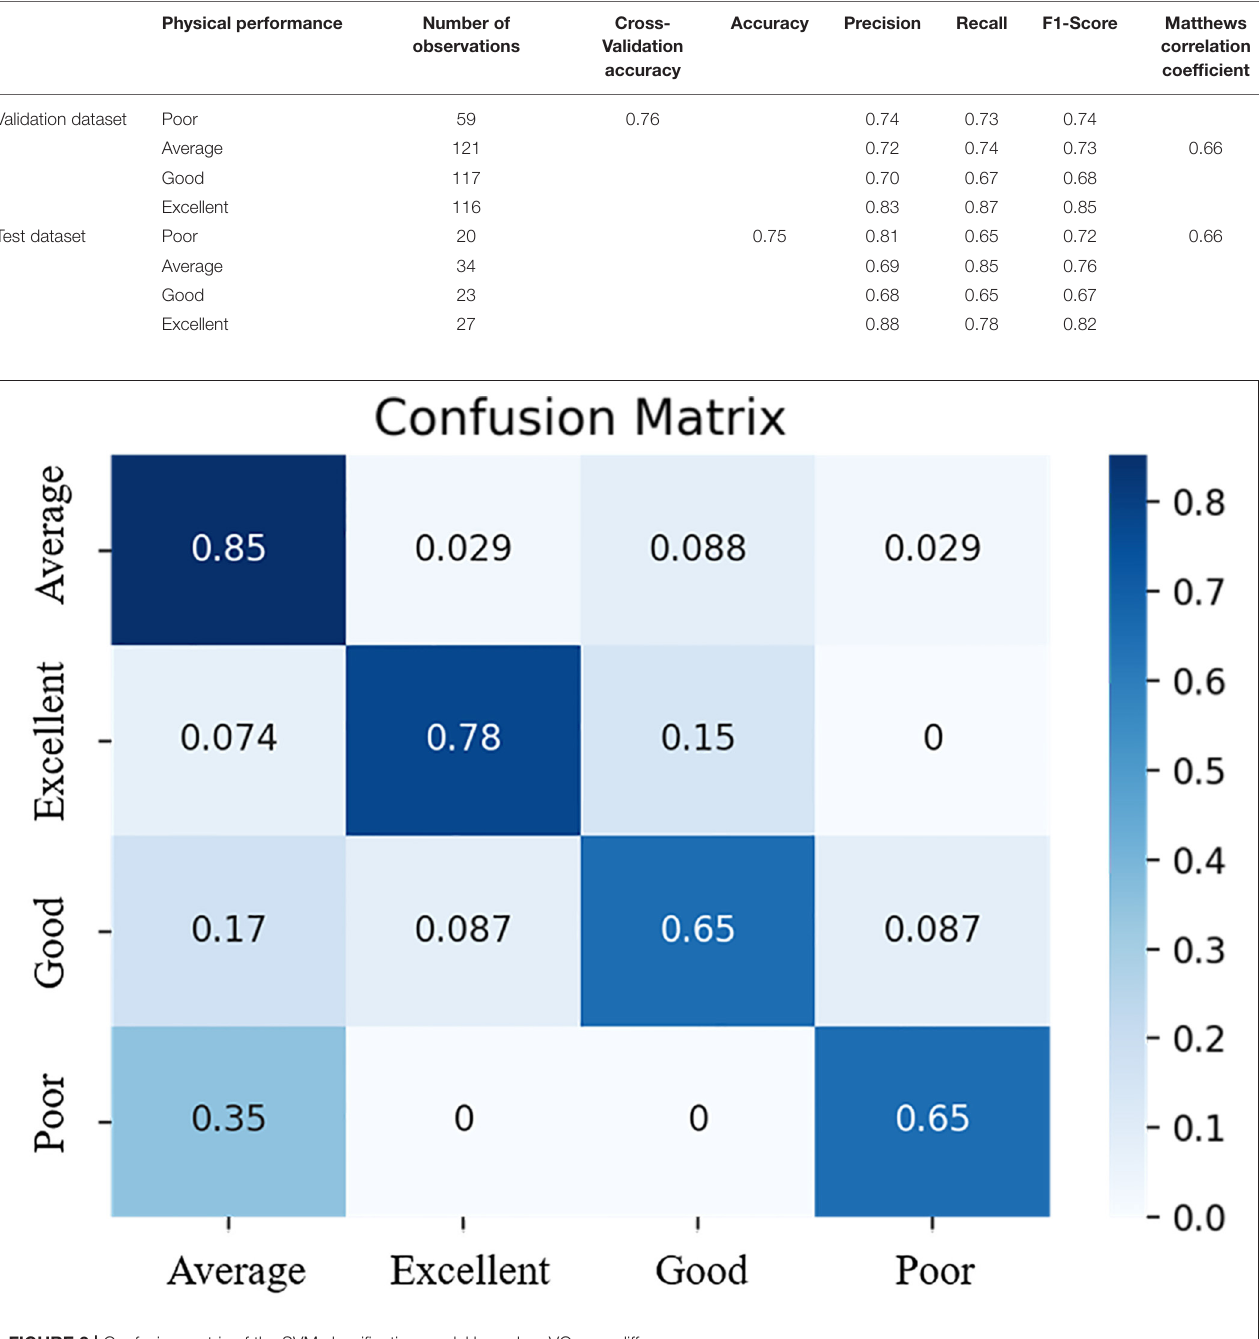
squares regression model in the age ≥ 40 group of the test dataset, with MAE = 3.2 ml/kg/min and RMSE = 4.26 ml/kg/min in the test